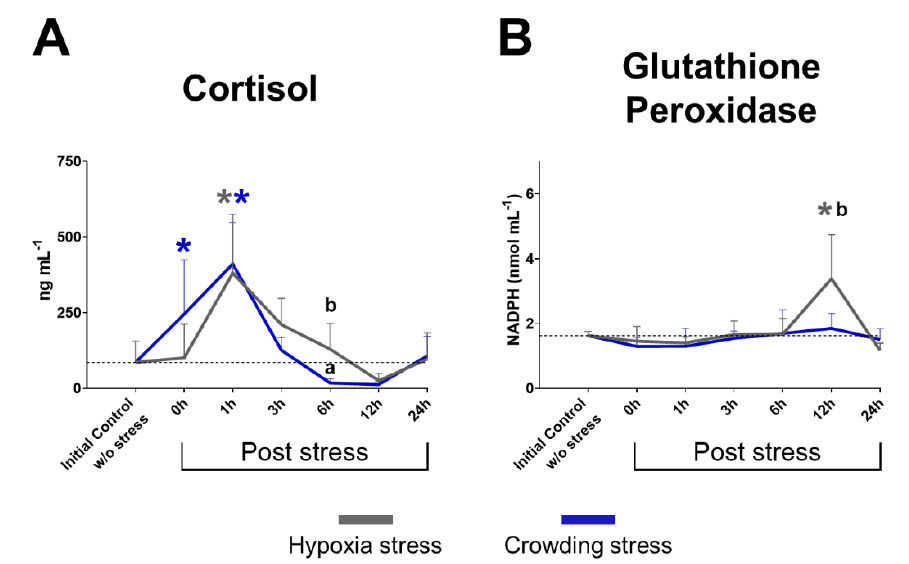
Figure 1. Plasma parameters in samples from Atlantic salmon. ( A ) Cortisol level (ng mL − 1 ). ( B ) Glutathione peroxidase (GPx) activity (NADPH (nmol mL −1 )). Sampling groups: initial control group (without stress) and 0, 1, 3, 6, 12, and 24 h post-stress. In grey, hypoxia stress; in blue, crowding stress. Values are presented as average cortisol values ± standard deviation. Significant differences ( p < 0.05) are denoted with * (grey *—hypoxia stress group compared with initial control group; blue *—crowding stress group compared with initial control group) and with the letters a and b (compared between stress models).